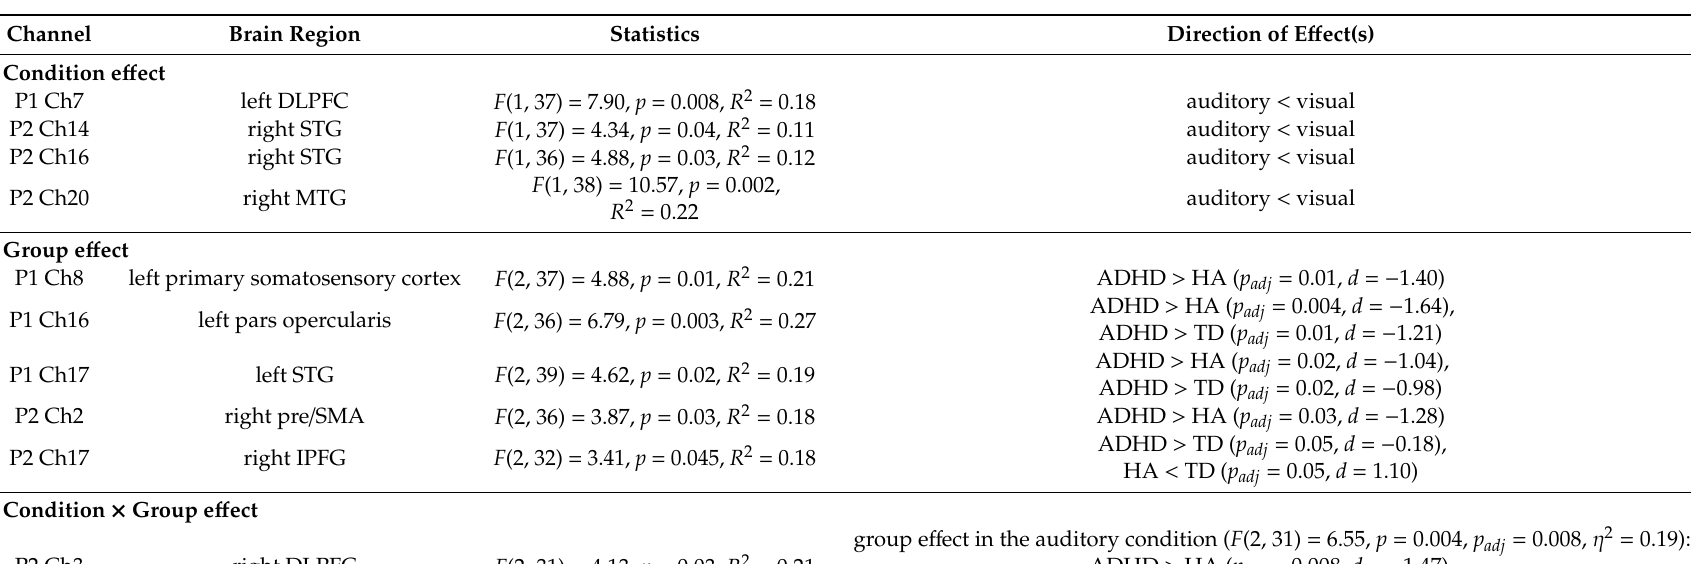
Table 4. E ff ects of group and condition on ∆